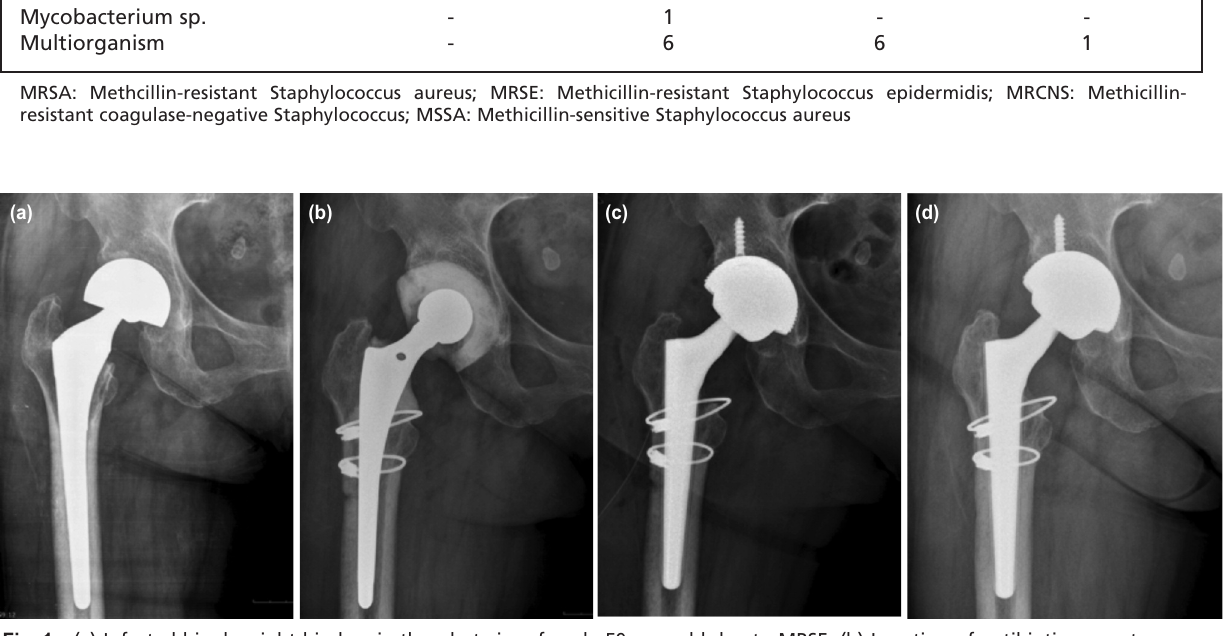
(a) Infected bipolar right hip hemiarthroplasty in a female 59-year-old due to MRSE. (b) Insertion of antibiotic cement spacer, Fig. 1: extended trochanteric osteotomy was needed to remove the infected femoral stem. (c) Revision THA was performed after 54 days interval period. (d) Radiograph of final follow-up at 33 months, patient has excellent clinical outcome with no sign of